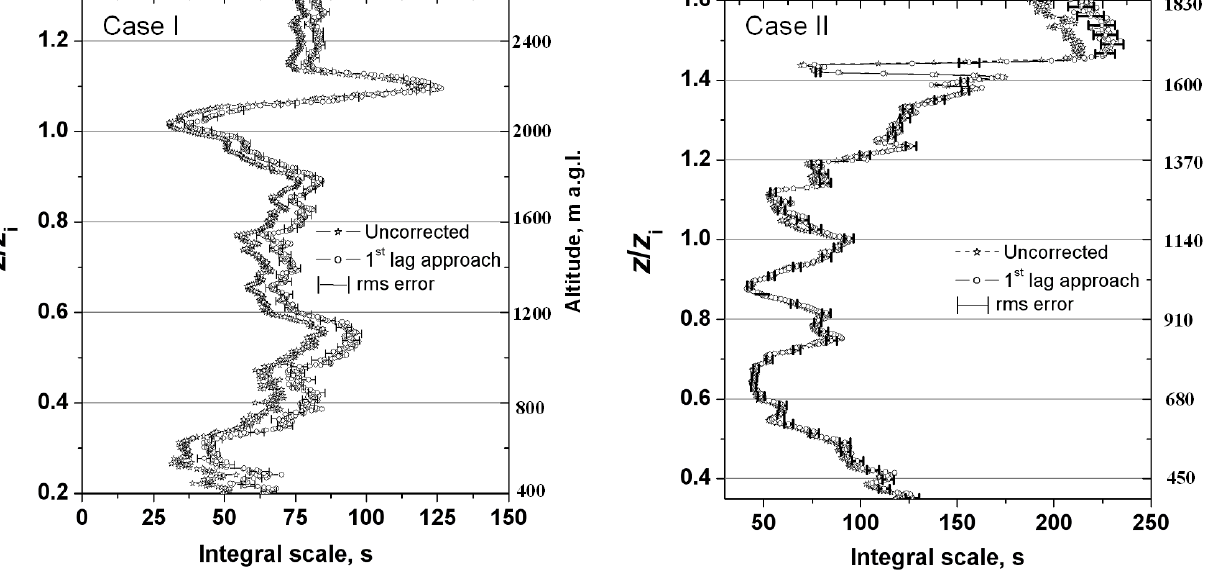
Fig. 11. The integral scale of particle backscatter coefficient fluctuations determined with and without noise correction for Case I (left) and Case II (right). The vertical coordinate is normalized with the mean boundary layer depth, i.e., the ratio of the height z and the mean CBL depth z i of 2008m and 1136m for Case I and Case II, respectively. The error bars on the profile obtained with 1st lag approach denote the standard error due to instrument